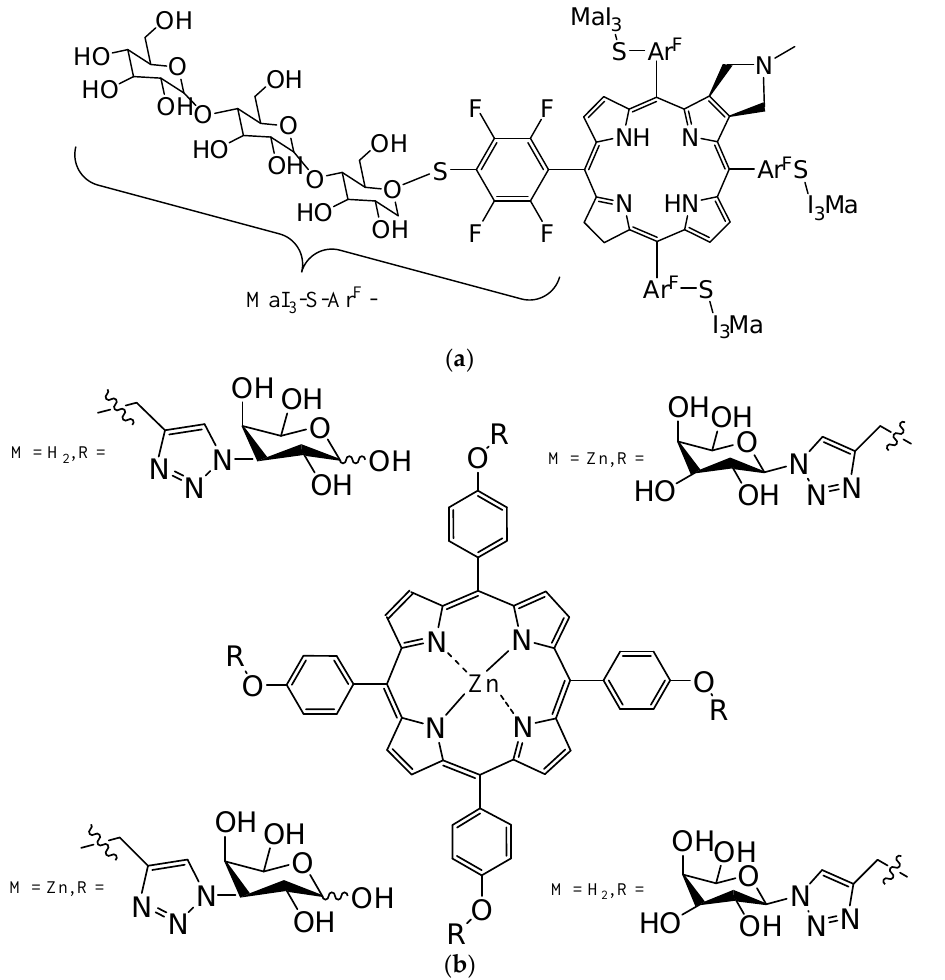
Figure 8. Structures of macrocycles photosensitizers functionalized with maltotriose (a) [185] or galactose (b) [185] fragments. galactose ( b ) [185]